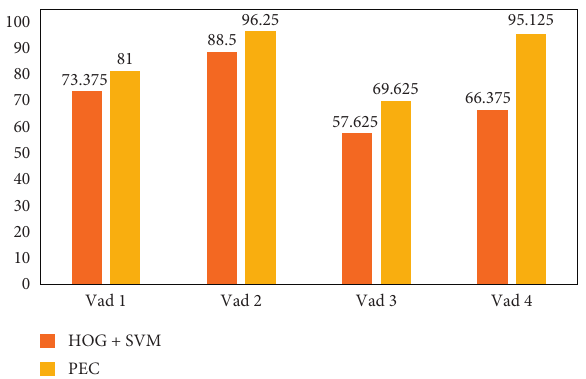
Figure 10: Comparison of the four validation performances be- tween the HOG+SVM classifier and the PEC: Vad 1: train and test with PSU data samples, Vad 2: train and test with INRIA data samples, Vad 3: train with PSU data samples and test with INRIA data samples, and Vad 4: train with INRIA data samples and test with PSU data